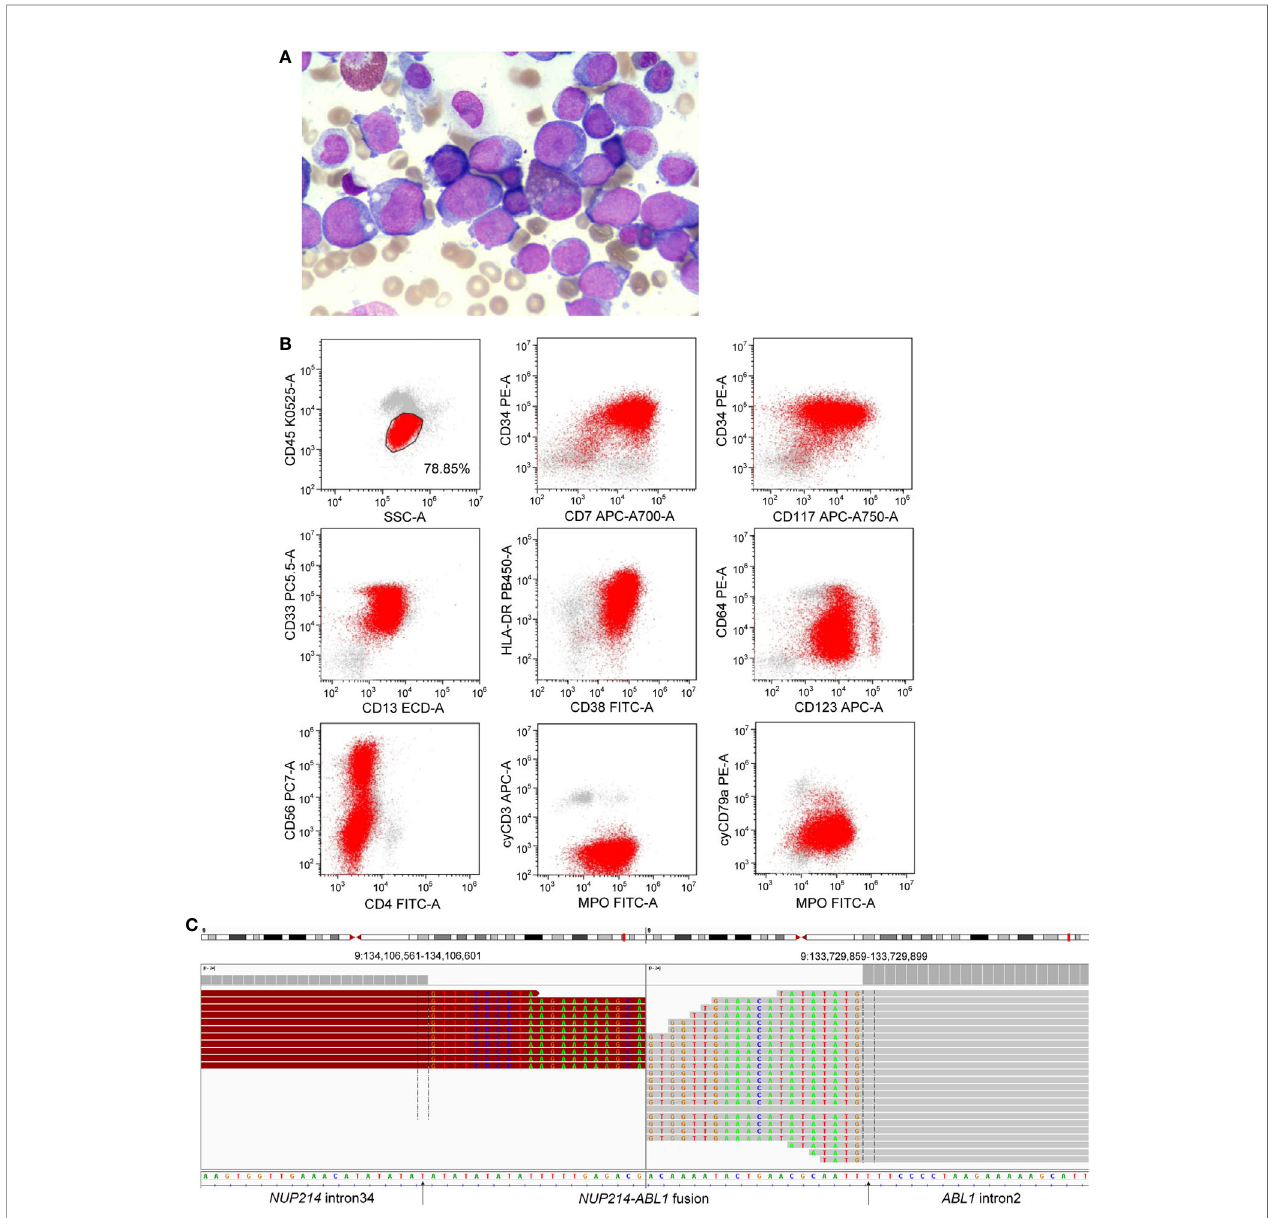
FIGURE 1 | (A) Morphological observation showed blasts in a bone marrow smear. (B) Immunophenotype of AML was determined by fl ow cytometry. (C) Next-generation sequencing revealed a breakpoint in intron 34 of NUP214 and a breakpoint in intron 2 of ABL1 , resulting in the NUP214 - ABL1 fusion